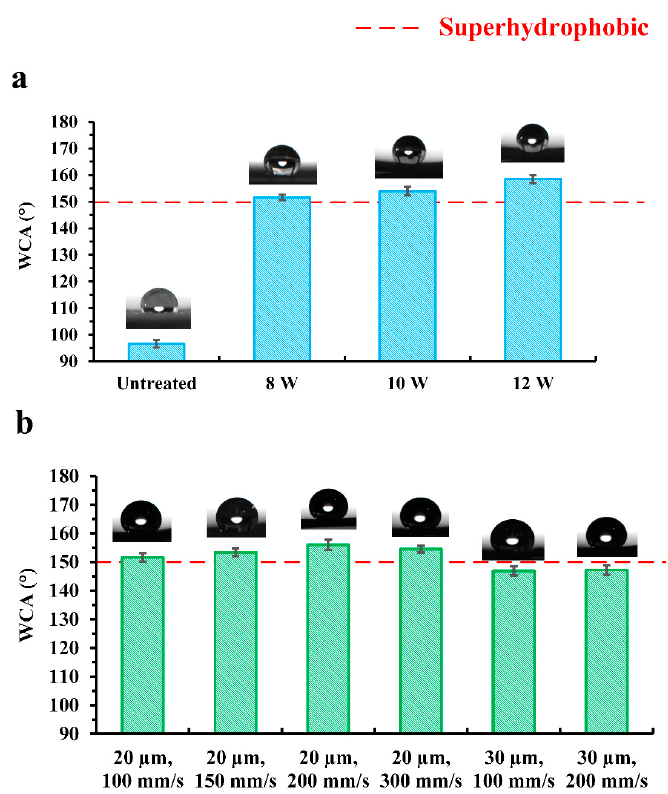
Figure 8. WCA measurement results for ( a ) untreated Cu foam and laser-heat treated Cu foams processed with different power levels and ( b ) laser-heat treated Cu foams processed using different combinations of scanning speed and line spacing.